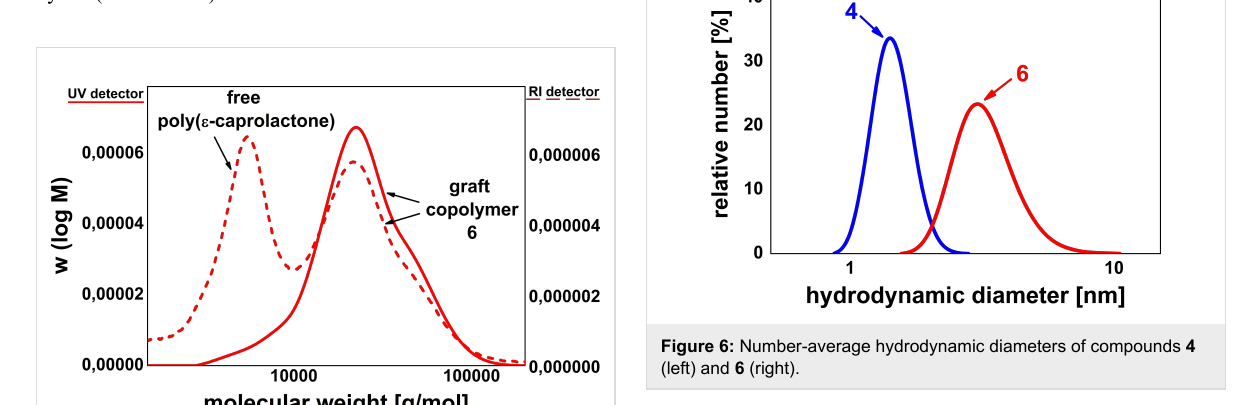
The DSC curve of grafted compound 6 shows a melting point ( T m ) at 50 °C while PCL homopolymer crystallizes at about 55 °C. Obviously the backbone of copolymer 6 reduces the crystalline